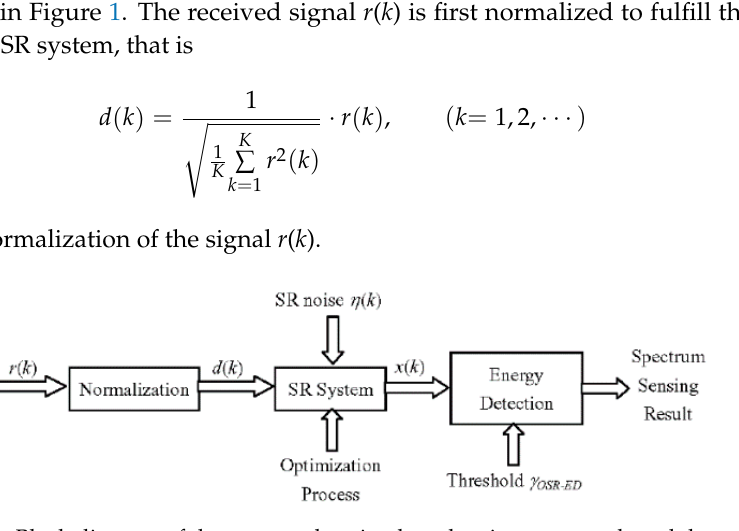
Figure 1. Block diagram of the proposed optimal stochastic resonance-based detector.